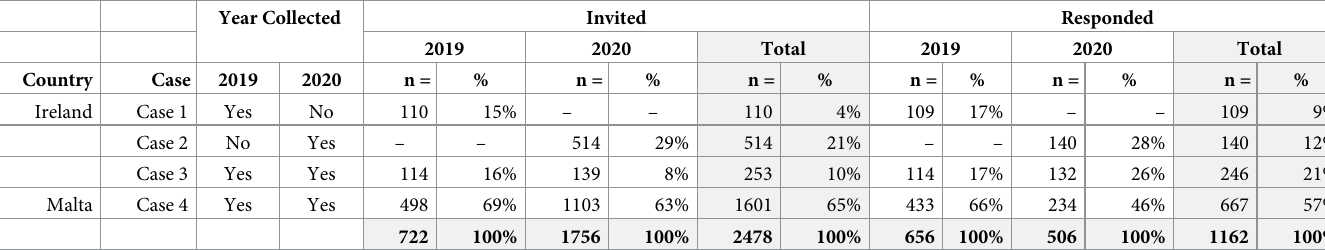
Table 3. Comparison of data collection by country, year and case.